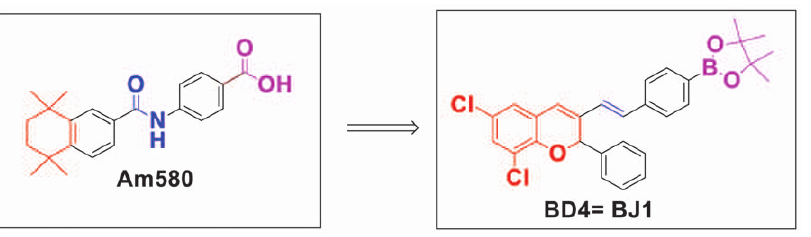
Figure 1. Synthesis of RAR a agonist BD4. We designed and synthesized a novel RAR a agonist, BD4, by making a bridge of a functional group (trans double bond) between hydrophobic chromene rings and benzoic acid or acid isosteres. The functional group was designed not only to increase the efficacy but also to reduce the toxicity of compounds. These modifications also increase the specificity for retinoic acid receptor isoforms. Characteristic features of BD4 are as follows: a) Our compound BD4 is oxaretinoid; b) Incorporation of oxygen heteroatoms to replace one of the gem-dimethyl groups in the tetrahydronaphthalene ring of Am580 decrease the toxicity by retarding metabolic oxidation; c) To protect against protease-mediated hydrolysis of amides bonds found in Am580, we introduced trans-double bond as amide isosteres in BD4, which is more resistant to proteolysis; d) Substitution of boronic acid and ester in BD4 in place of acids generates a more biologically active molecular frameworks, which allows BD4 to interact with a target protein through both hydrogen bonds and covalent bonds. This interaction is predicted to produce more potent biological activity.